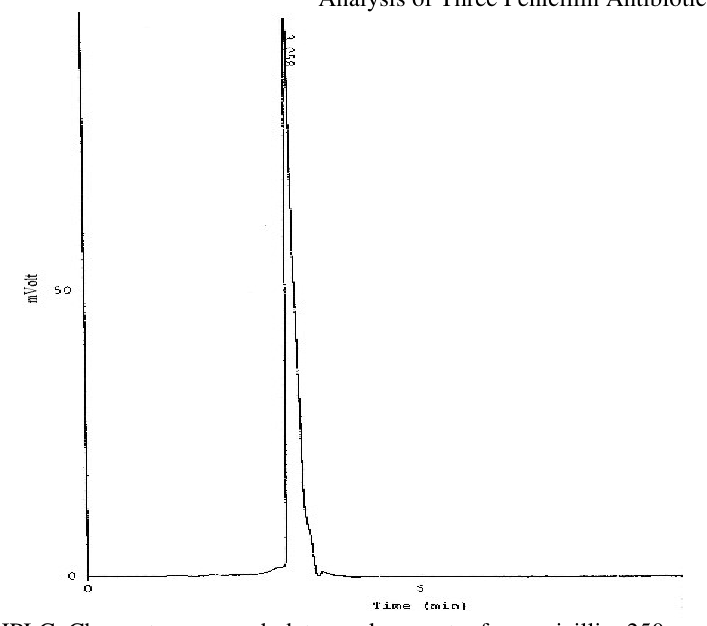
Figure 3. HPLC Chromatogram and data peak report of amoxicillin 250 mg capsules manufactured by Farabi Pharmaceutical Co. of Iran. Ret.Time